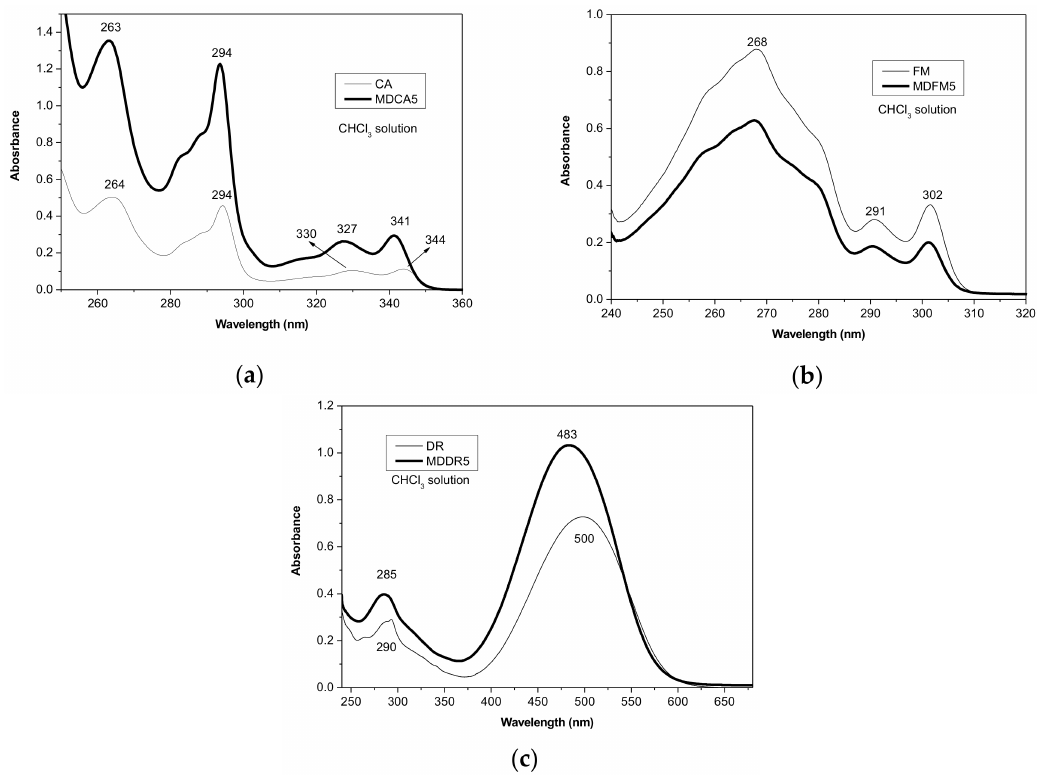
Figure 5. Ultraviolet-visible (UV-vis) absorption spectra in chloroform solution of ( a ) CA and MDCA5, ( b ) 9-fluorenyl-methanol (FM) and MD prepared by using 5 mol% of FM (MDFM5), and ( c ) 2-(4-(2-chloro-4-nitrophenylazo)-N-ethylphenylamino)ethanol (DR) and MD prepared by using 5 mol% of DR (MDDR5): see Section 2.6 for